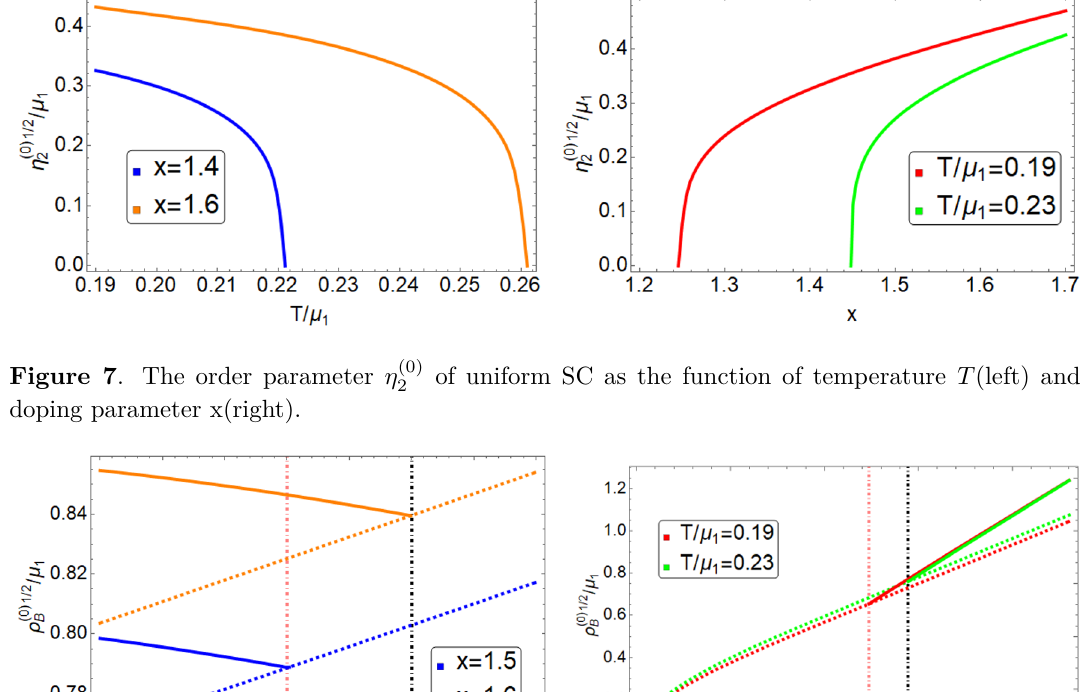
Figure 8 . The charge density ρ (0) as the function of temperature T (left) and doping parameter B x(right). The solid lines in color stand for ρ (0) after condensation, while the dashed lines in color B stand for ρ (0) in RN black hole. The vertical lines denote the location of SC phase B